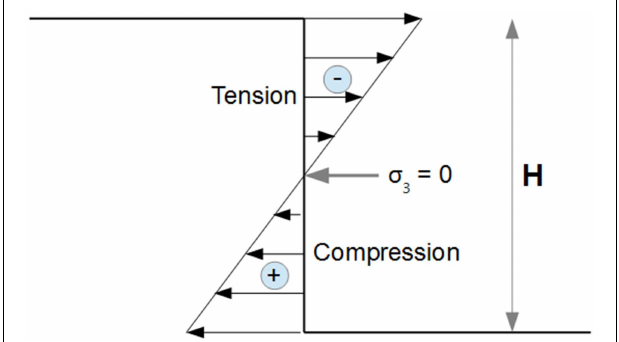
FIGURE A1 | The σ 3 distribution as a function of H along a vertical wall (after Philipponat and Hubert,